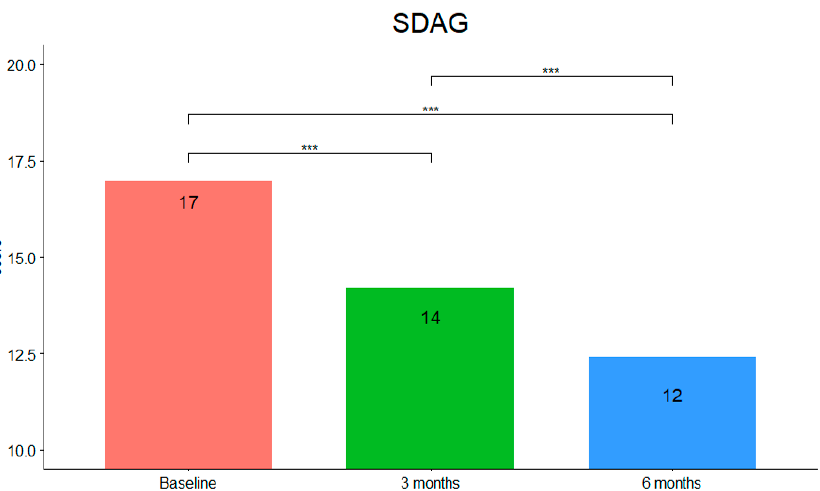
Figure 3. MERS mean scores at the three timepoints (***: p -value < 0.001; ns, not significant). SDAG scores (see Figure 4) showed that they were statistically significantly different at the different time points during tPBM intervention (F (2,40) = 39.966, p < 0.001, η 2 g = 0.574). Pairwise comparisons using the Bonferroni correction showed that there was a decrease in SDAG scores from pre-intervention to three months ( p < 0.001) and from pre-intervention to six months ( p < 0.001) as well as from three to six months ( p < 0.001).